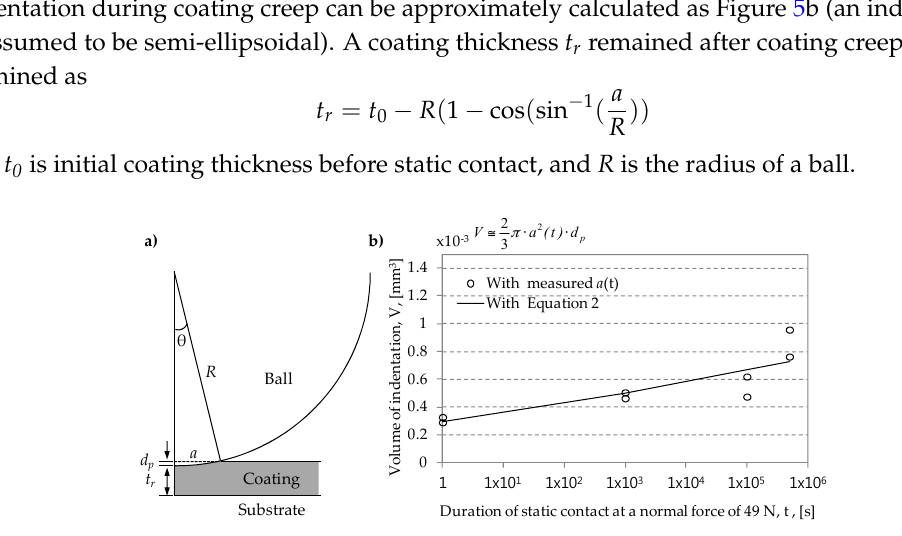
Figure 5. Determination of indented volume: ( a ) schematic diagram of static contact between a hard ball and a soft coating; ( b ) estimated volume of indentation after unloading. d p denotes the penetration displacement.